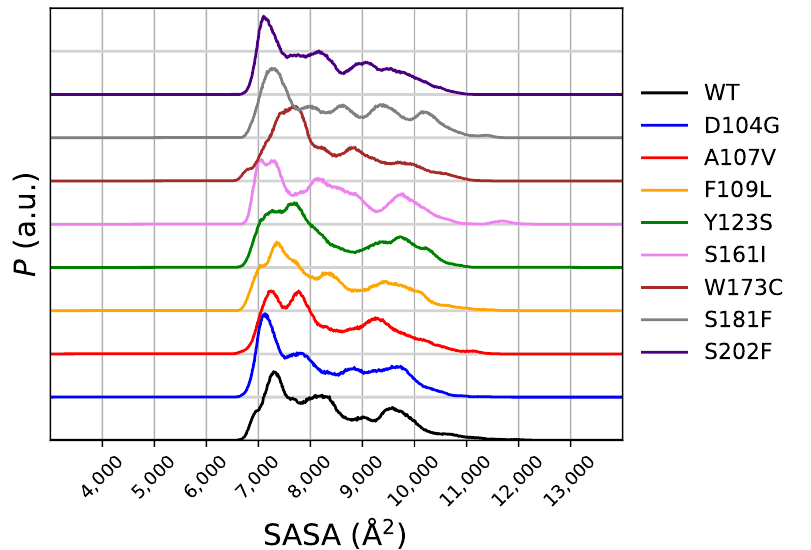
Figure 7. Distribution of solvent-accessible surface area (SASA) obtained in meta-statistics for all studied variants. The order is the same as for Figure